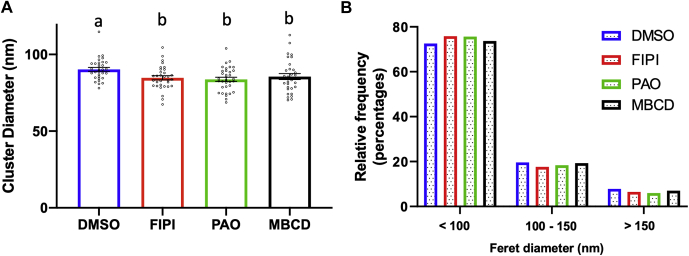
Influence of PIP2, PA, and cholesterol on EGFR nanocluster size in mouse colonic cells. YAMC cells were incubated with DMSO (0.1%), FIPI (1 μM), PAO (1 μM), or MβCD (10 mM) for 30 min at 33°C, before fixation and labeling with EGF-Alexa647 for STORM imaging. A: Quantitative analysis of EGFR cluster diameter and (B) relative frequency in YAMC cells. Data are presented as (A) mean ± SE of average EGFR cluster diameter per FOV and (B) individual cluster size distribution. Number of FOVs examined per treatment, DMSO = 32, FIPI = 32, PAO= 34, and MβCD = 31, and individual clusters, DMSO = 3,559, FIPI = 2,443, PAO = 1,512, and MβCD = 2,700, from 3 wells per group from 3 independent experiments. Statistical significance between treatments as indicated by uncommon letters (P < 0.05) was analyzed using one-way ANOVA and uncorrected Fisher's LSD tests.